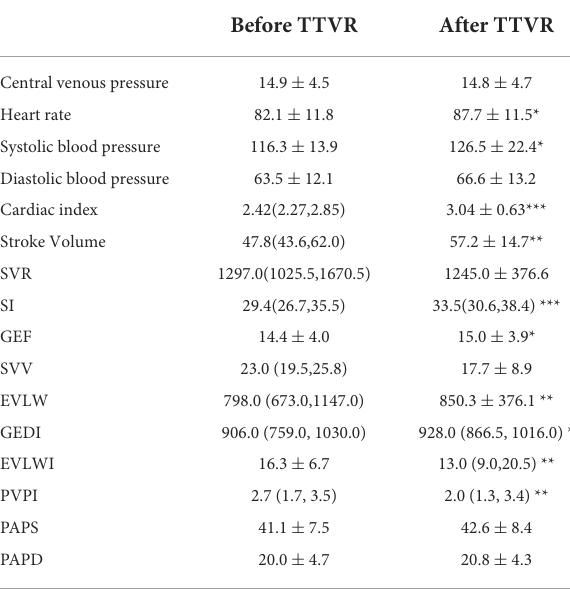
TABLE 3 Perioperative outcome. TABLE 4 PICCO results.